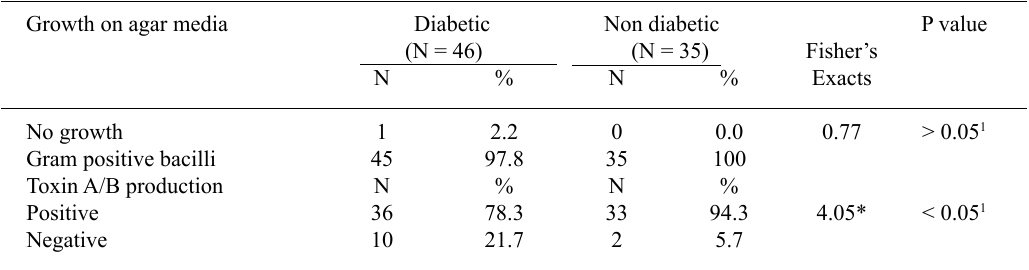
table 4. Growth on Clostridium difficile agar medium and toxin A/B in diabetic and non-diabetic groups Growth on agar media